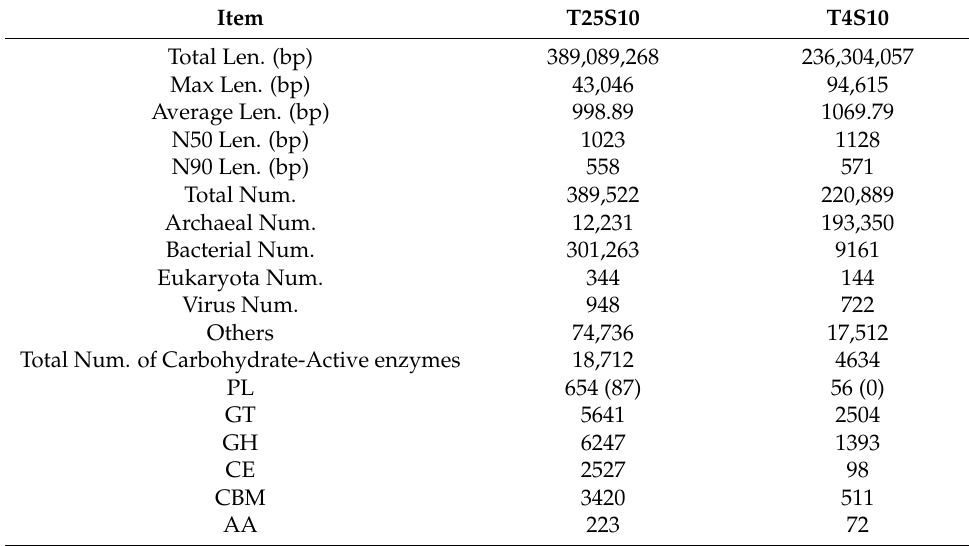
Table 2. Library information of microbial metagenome sequencing of rotten (T25S10) and unrotten (T4S10) salted kelp samples. Item T25S10 Total Len.